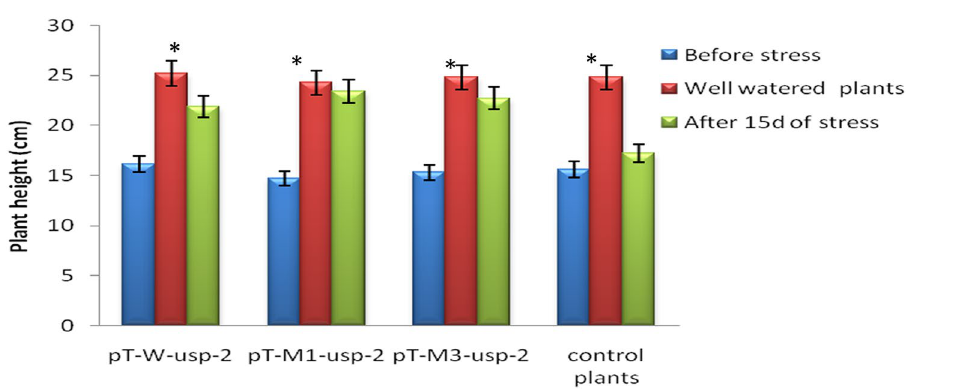
Figure 12. Comparison of Plant height (cm) of pT- W-usp-2 , pT- M1 -usp-2 , pT- M3-usp-2 plants under control and drought stress